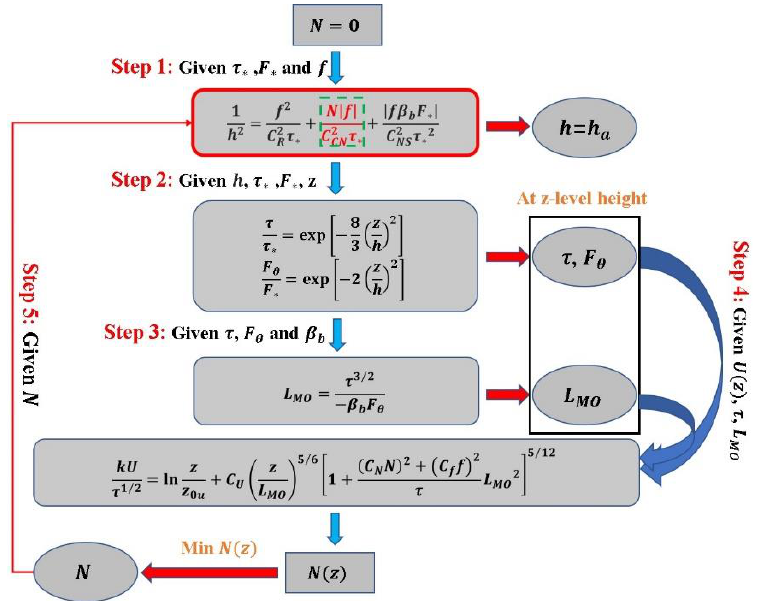
Figure 4. Flow chart for calculating ℎ including 5 steps. Step 1: assuming 𝑁 = 0 , ℎ 𝑎 is calculated with given 𝜏 ∗ , 𝐹 ∗ and 𝑓 ; step 2: 𝜏 and 𝐹 𝜃 at each z- level height (z = 50, 100,…, 400 m) are estimated with ℎ 𝑎 , 𝜏 ∗ , 𝐹 ∗ and 𝑧 ; step 3: calculating 𝐿 𝑀𝑂 at z- level heights using 𝜏 , 𝐹 𝜃 and 𝛽 𝑏 ; step 4: based on 𝑈(𝑧) , 𝜏 and 𝐿 𝑀𝑂 , calculating 𝑁 at z-level heights and taking the minimum value of 𝑁(𝑧) ; step 5: substitute 𝑁 into Equation (2) in the first step, and the ℎ can be determined ultimately.